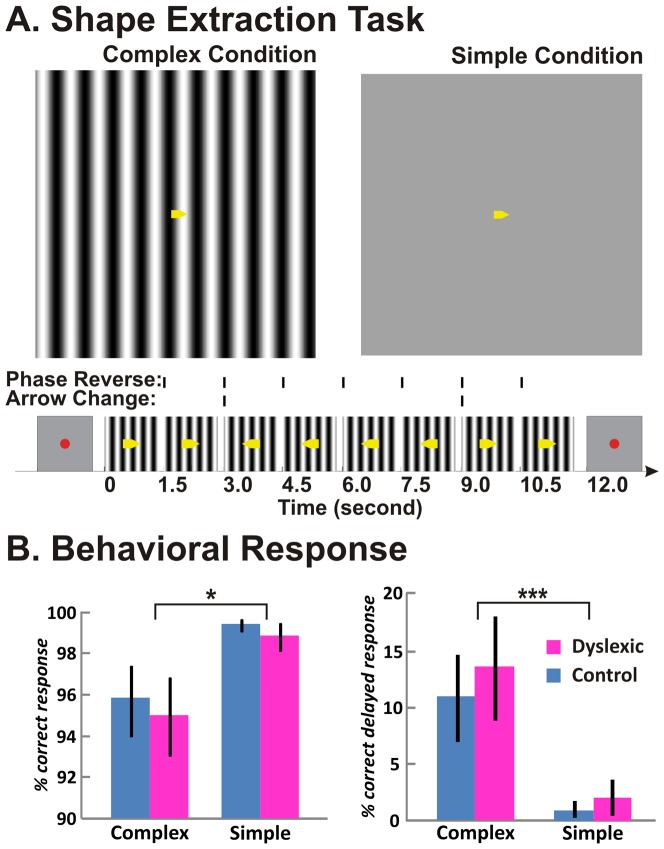
Task and performance.(A) The shape extraction task was performed under the complex condition with a large grating background (left panel) and the simple condition with a uniform gray background (right panel). The task had a 3-second fixation period and a 12-second block of stimulus period. During the stimulus period, participants were instructed to push the response button as soon as they saw a change in arrow direction. (B) The control and dyslexic groups performed similarly on the shape extraction task. The left panel shows that, for both groups, response accuracy was significantly lower for the complex condition than for the simple condition. The right panel shows that the percent of delayed, but correct, responses was significantly greater for the complex condition than for the simple condition. * p<0.01, ** p<0.005. Error bars indicate SEM within group.